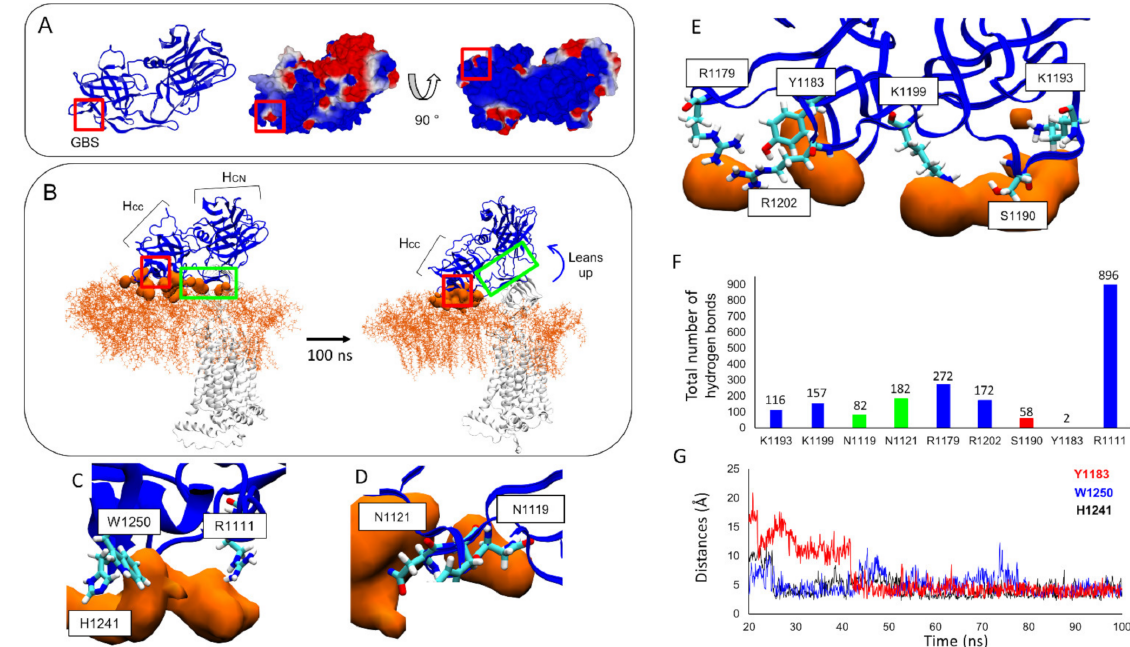
Figure 6. Electronic surface of the Hc domain of BoNT/F1, seen from the GBS side (middle) or the membrane surface side (right). The red color represents a globally anionic surface, the white color represents a neutral surface and the blue color represents a cationic surface ( A ). Neural-membrane- surface-induced conformational changes of the Hc domain of BoNT/F1. GT1b ganglioside molecules are represented as orange lines, and the GT1b atoms that were between 2.5 and 5 Å of the surface of BoNT/F1 are depicted as orange surfaces. BoNT/F1 is depicted as blue and hSV2Ag as white. Glycan content of hSV2Ag is not represented in these snapshots ( B ). Molecular details of residues in GBS interacting with gangliosides ( C ). Molecular details of interaction of two residues belonging to a flexible loop structure ( D ). Description of molecular interaction of residues that belong to a region in BoNT/F1 that is homologous to the synaptotagmin binding pocket ( E ). Histogram showing the total hydrogen bonds formed by each residue during the simulation ( F ). Plot showing the distance between gangliosides and aromatic-residue atoms that were engaged in CH- π or OH- π interactions ( G